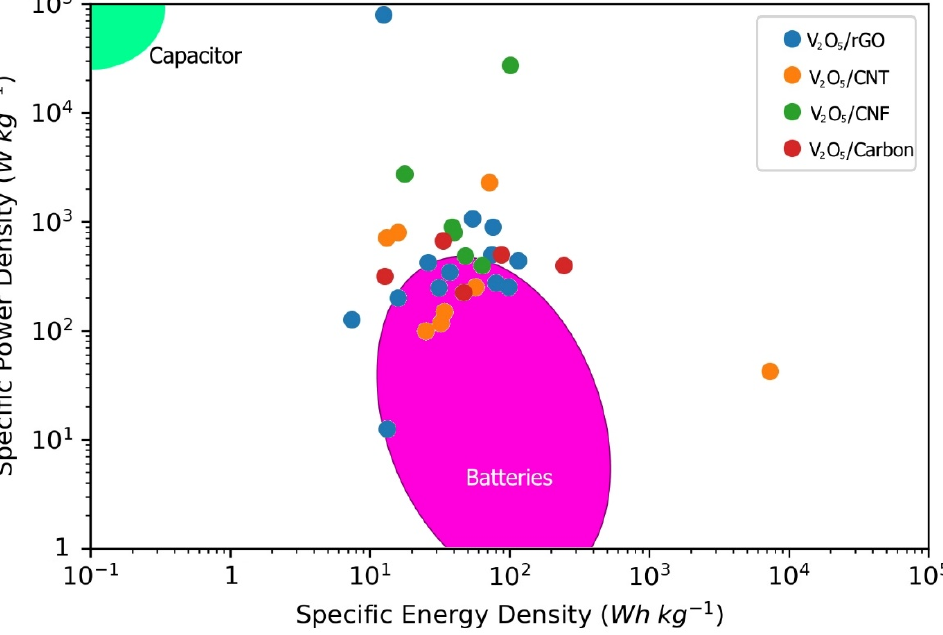
Figure 1. Ragone plot showing the energy and power density ranges of common electrochemical energy storage devices such as capacitors, supercapacitors, and batteries.